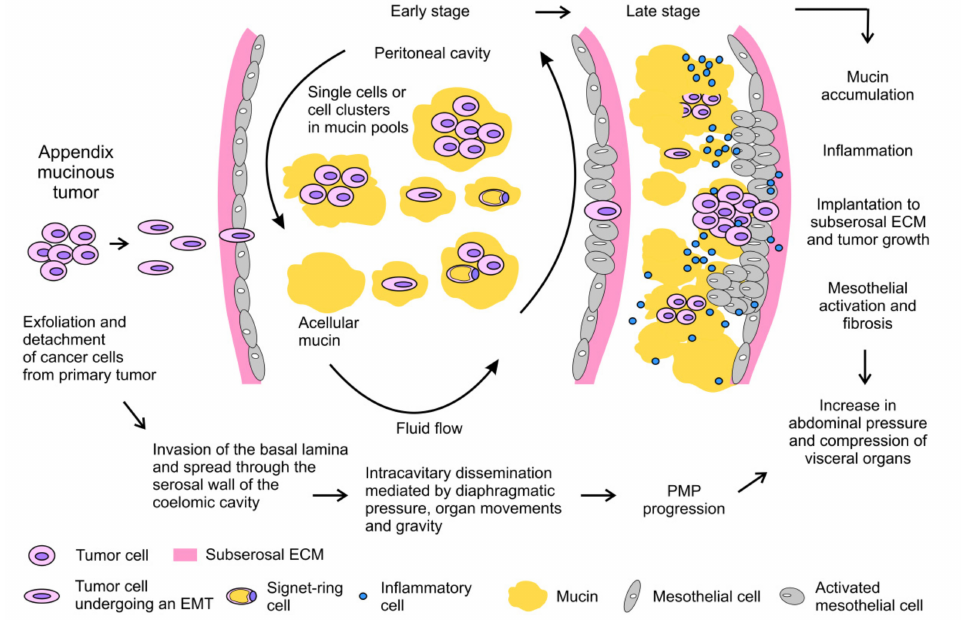
Figure 2. Transcoelomic spread of tumor cells, PMP development and progression. Tumor cells induced to undergo an epithelial–mesenchymal transition (EMT) detach from the primary tumor and invade the peritoneal cavity through the serosal wall. The malignant seeding of mucin-producing single cells and cell clusters into the abdominal cavity is regulated by peritoneal fluid dynamics. Ascitic fluid flow is influenced by the movements of the diaphragm and the abdominal muscles, the peristaltic movements of the intestinal tract and by gravity. The presence of signet-ring cells denotes an aggressive, high-grade PMP. Peritoneal implants are generated by the attachment of tumor cells mainly at sites of fluid reabsorption. The tumor cells invade the subserosal extracellular matrix (ECM) and proliferate. Tumor progression is accompanied by massive mucin accumulation, inflammation and fibrosis of the mesothelial